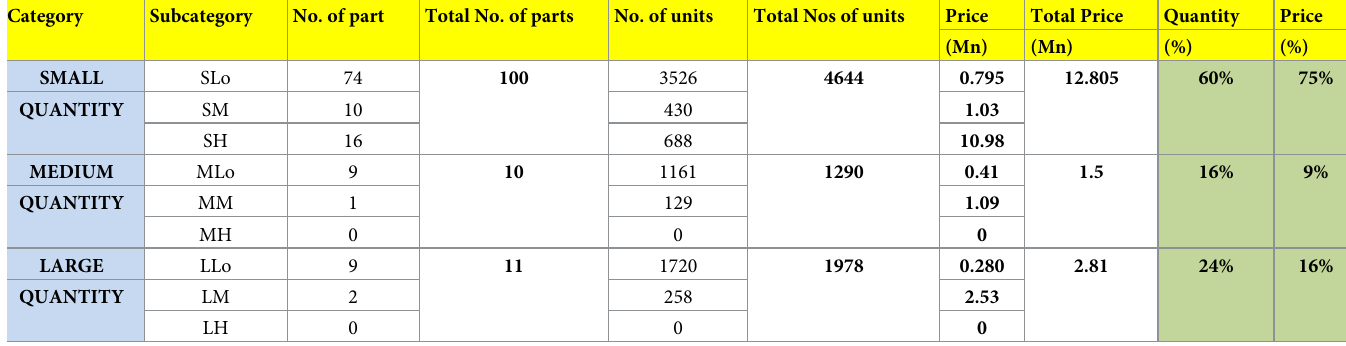
Table 6. Quantity based